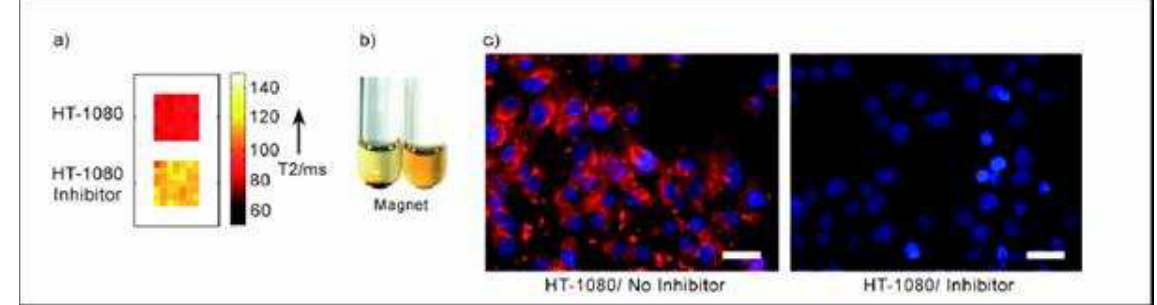
Figure 15. In the presence of tumor derived cells (HT-1080), MMP-2 is secreted. (a) T2 mapping of Fe O nanoparticles. In the presence pf an MMP-2 inhibitor (Galardin) no variation in the T2 3 4 relaxation time is observed. 5c) aggregation is observe when incubating the nanoparticles with HT- 080, while it is inhibited in the presence of galardin ( Reprinted from [29] with permission from Wiley VCH